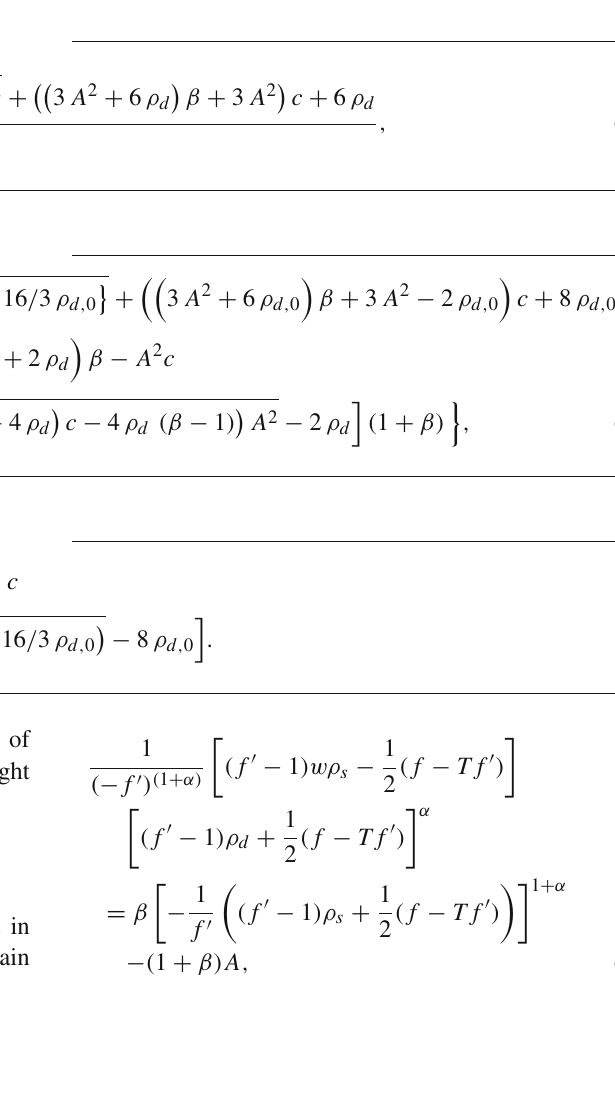
Fig. 16 ξ 1 , 2 , 3 , 4 and χ 1 , 2 , 3 , 4 versus a for dust-torsion for MGCG model. We use β = 2, c = 1 . 9 and A = 0 . 8 for all numerical